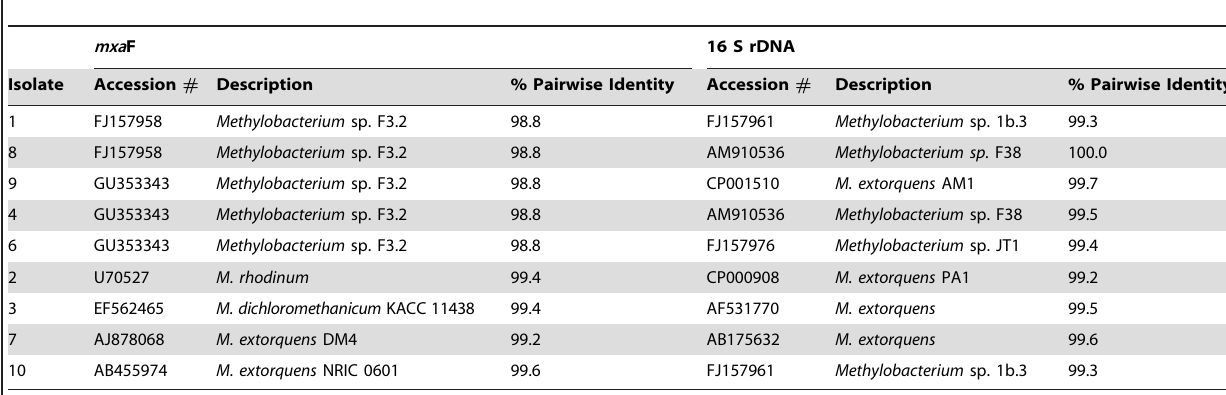
Table 2. Comparison of most similar cultured isolate to GenBank Sequences (blastn) for 16 SSU ribosomal DNA and the methanol dehydrogenase gene, mxa